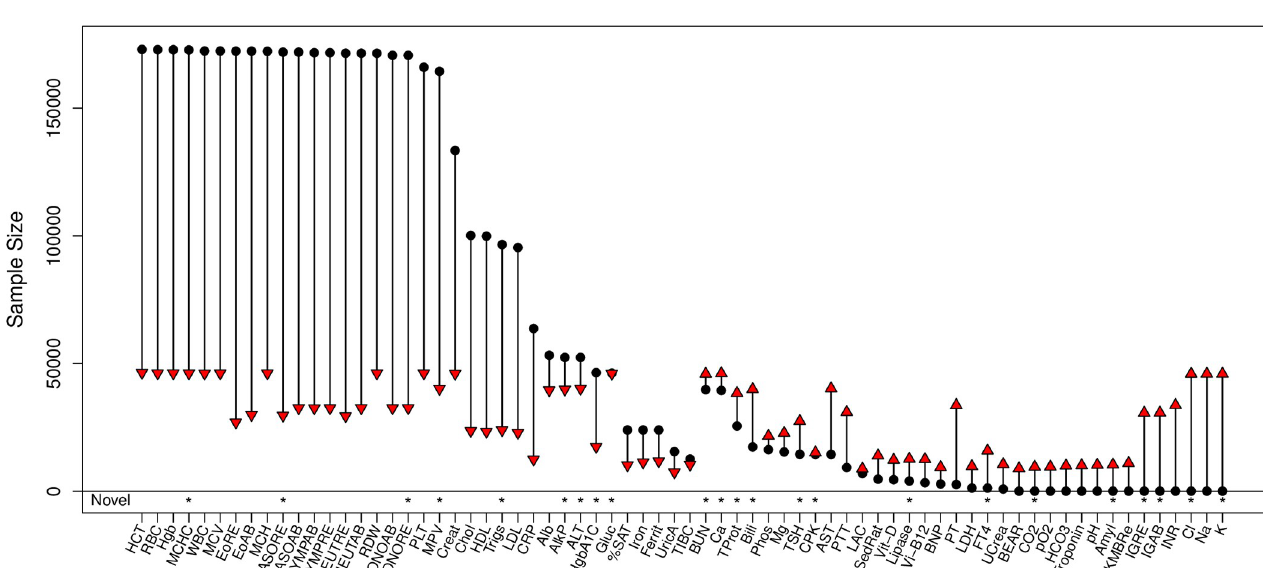
Fig 2. Sample sizes for 70 clinical lab traits from the meta-analysis of BioVU and MGI EHRs (red triangles) and the previous largest reported GWAS in a European cohort (black circles). Our meta-analysis provides the largest GWAS for 34 lab traits, including the first for 14. Asterisks along the bottom row indicate labs for which we identified a novel genetic